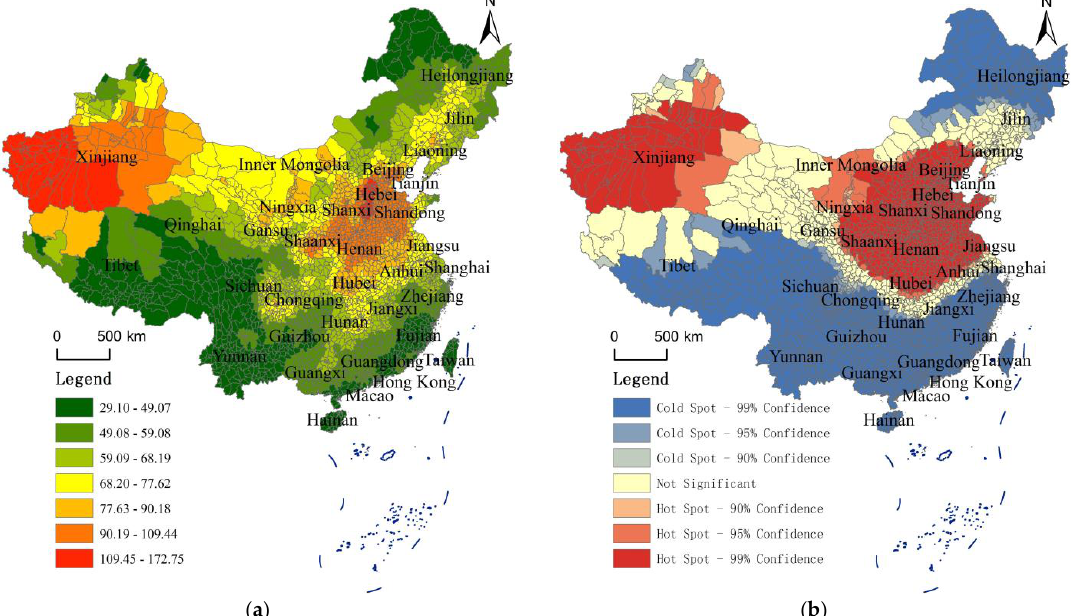
Figure 3. Distribution Pattern and Analysis Results of Getis – Ord Gi* of Air Quality Index (AQI) Based on the Levels of County. ( a ) Average AQI distribution of counties in China from 2014 to 2021; ( b ) analysis of cold and hot spots of average AQI of counties in China from 2014 to 2021.